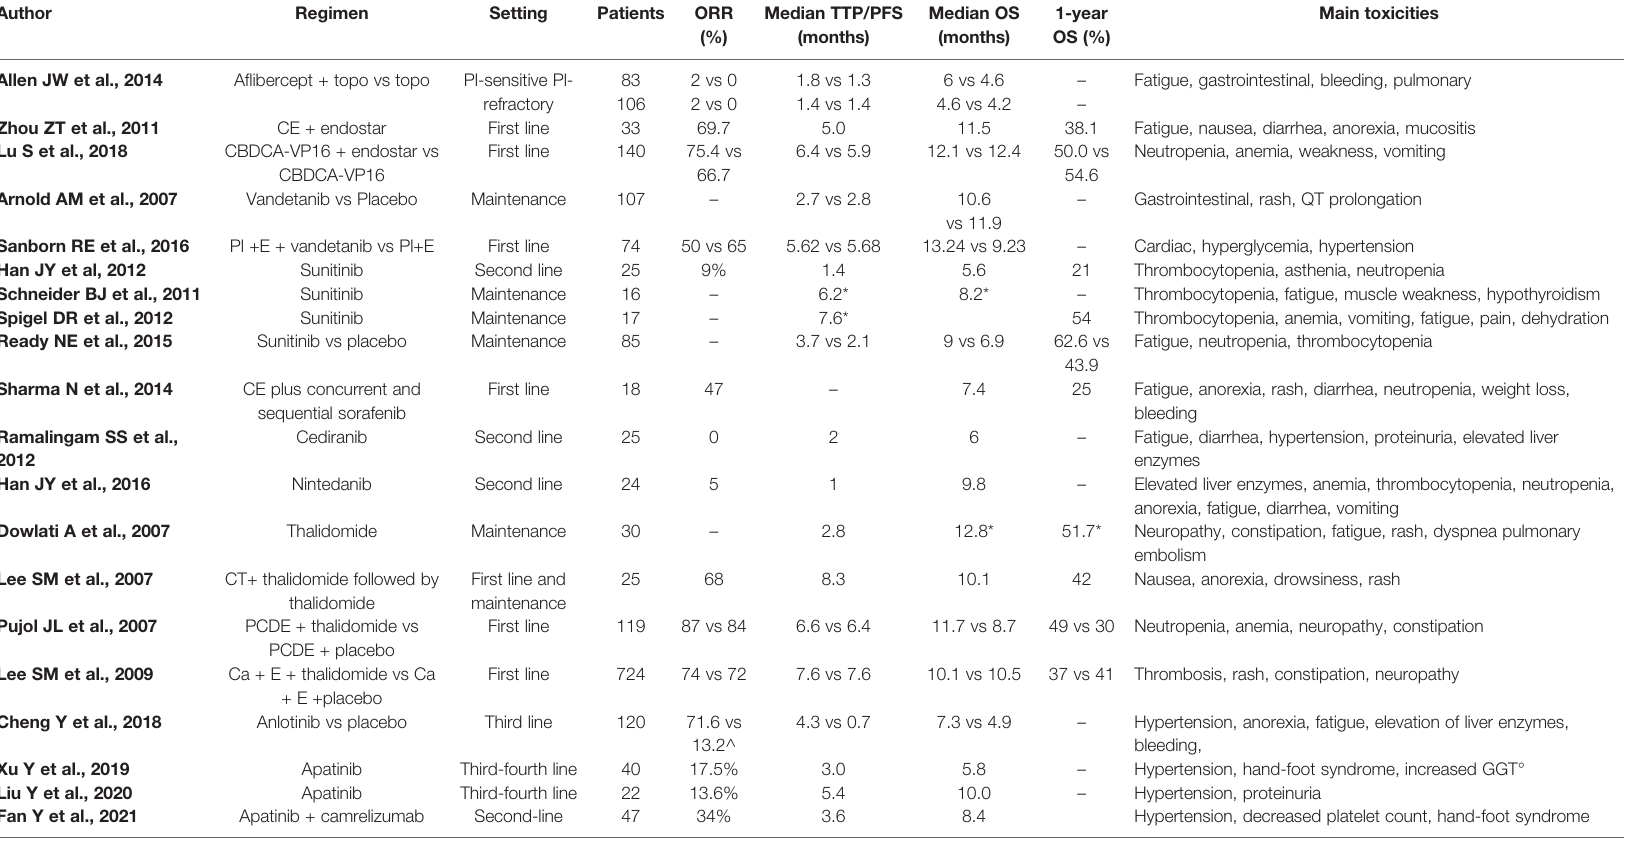
TABLE 2 | Other angiogenesis inhibitors in